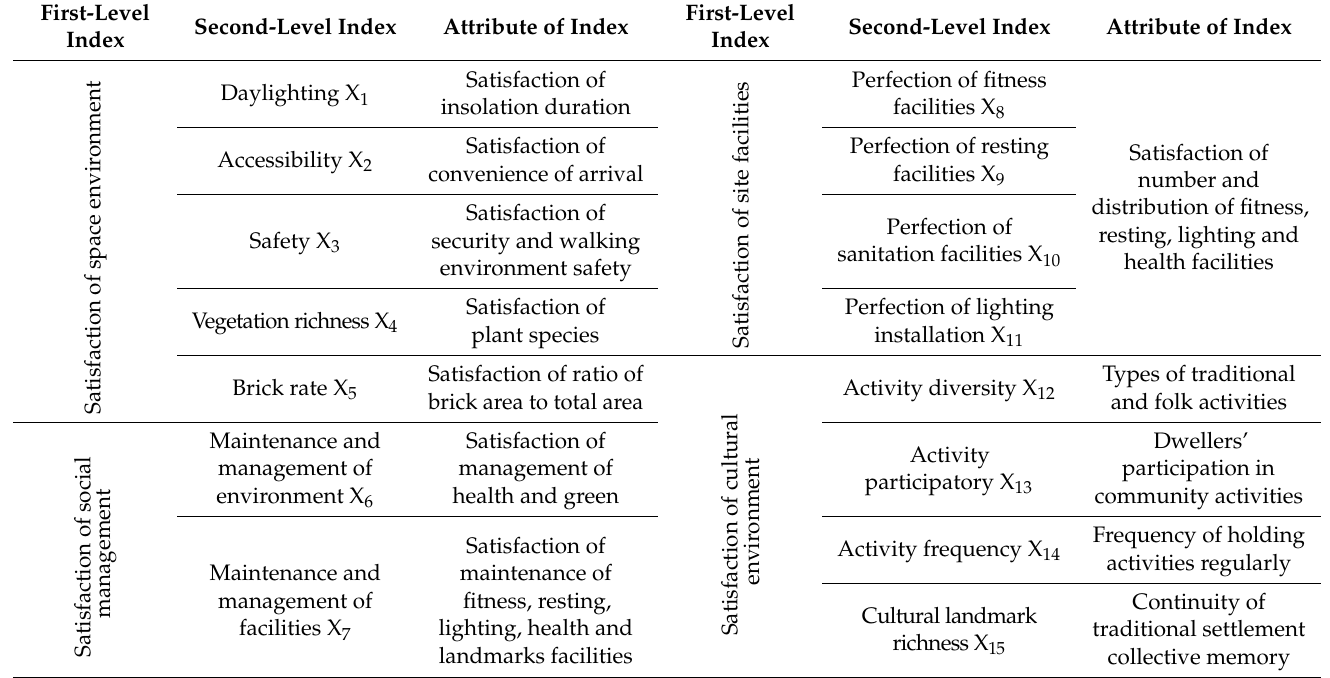
Table 2. Attribute characteristics of public space satisfaction evaluation indexes of a new centralized community.